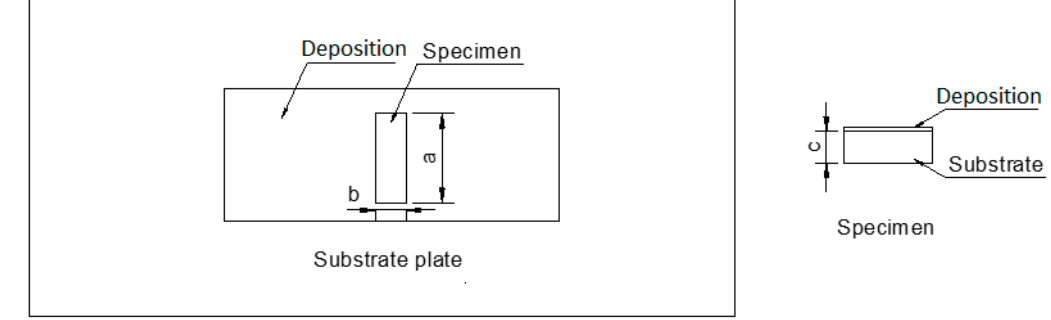
Figure 4. Metallographic specimens.